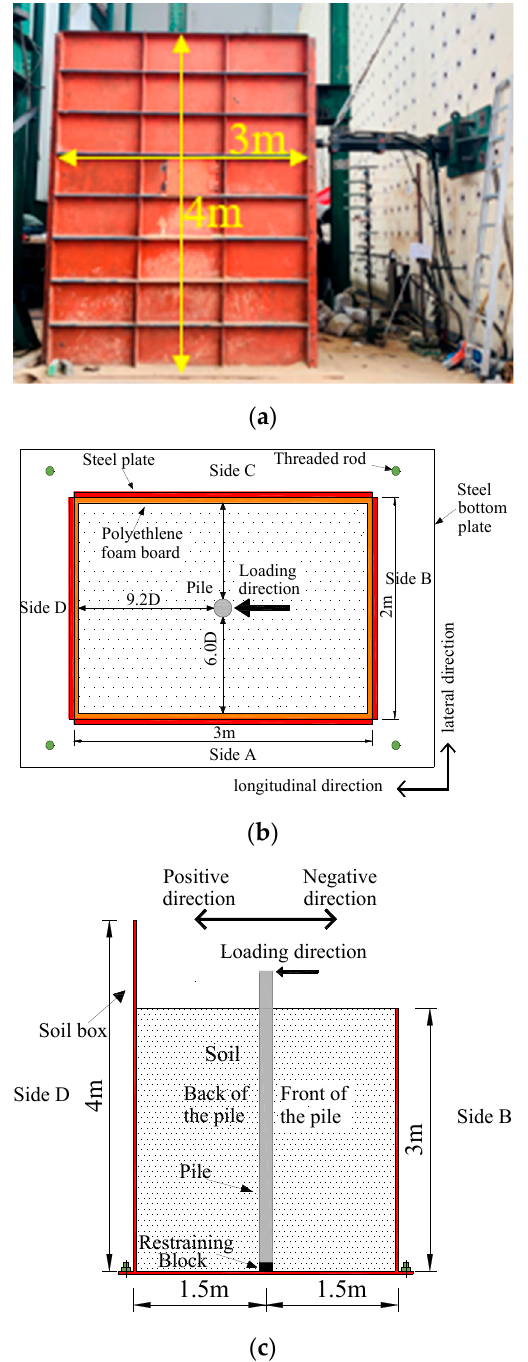
Figure 3. Soil box and test setup layout. ( a ) Soil box. ( b ) Top view of specimen and soil box. ( c ) Elevation view.